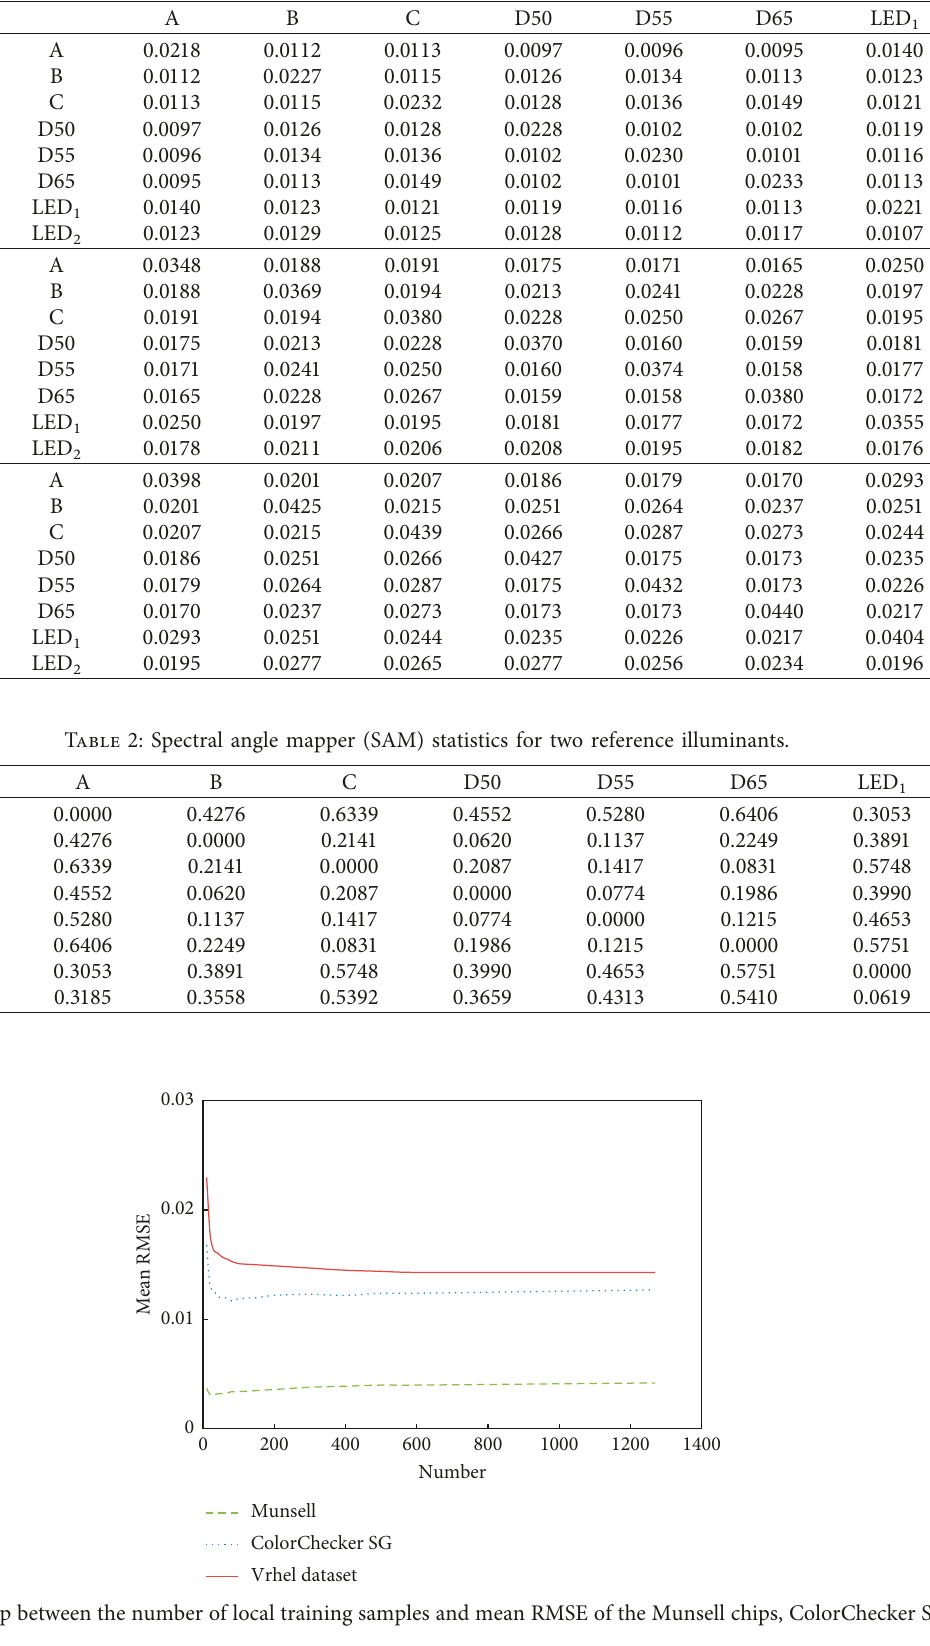
Table 1: Mean RMSE of the Munsell chips, ColorChecker SG, and Vrhel dataset under two illuminant combinations.